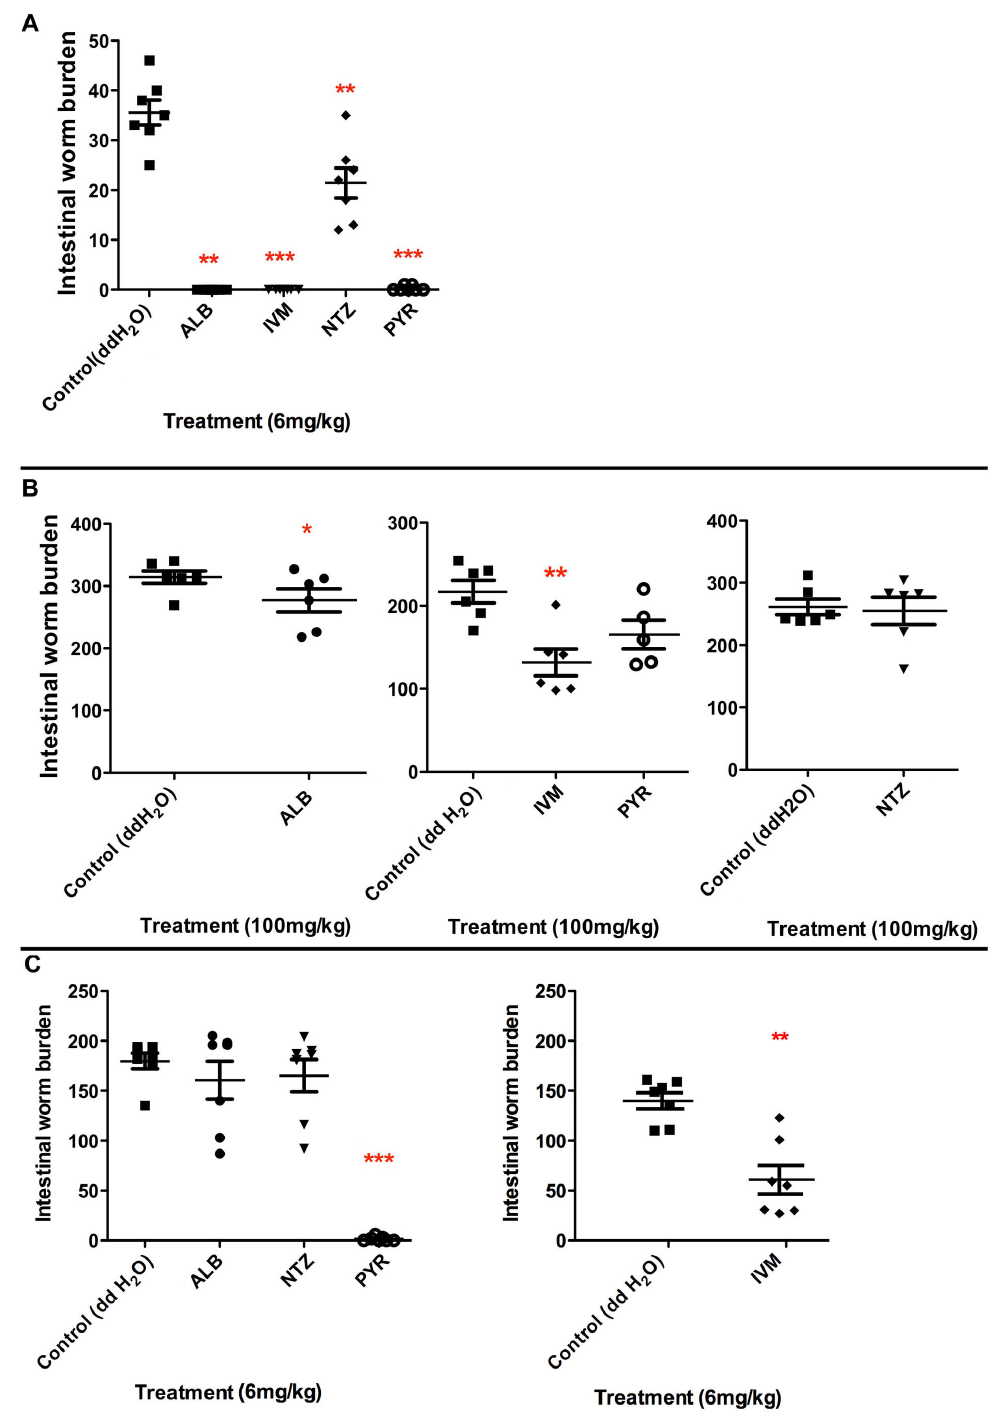
Figure 6. In vivo efficacies of albendazole (ALB), ivermectin (IVM), nitazoxanide (NTZ), and pyrantel (PYR) against A) A. ceylanicum infections in hamsters; B) T. muris infections in STAT6-/- mice; and C) H. bakeri infections in Swiss Webster mice. Shown are the intestinal worm burdens after treatment per os with the drugs in comparison to placebo (water-only) control. Worm burdens shown in separate panels for the same parasite are from separate experiments; worm burdens shown in the same panel for the same parasite are from a single experiment. P values relative to placebo control are as follows: * < 0.05; ** < 0.01; *** < 0.001. doi: 10.1371/journal.pone.0070702.g006 PLOS ONE |